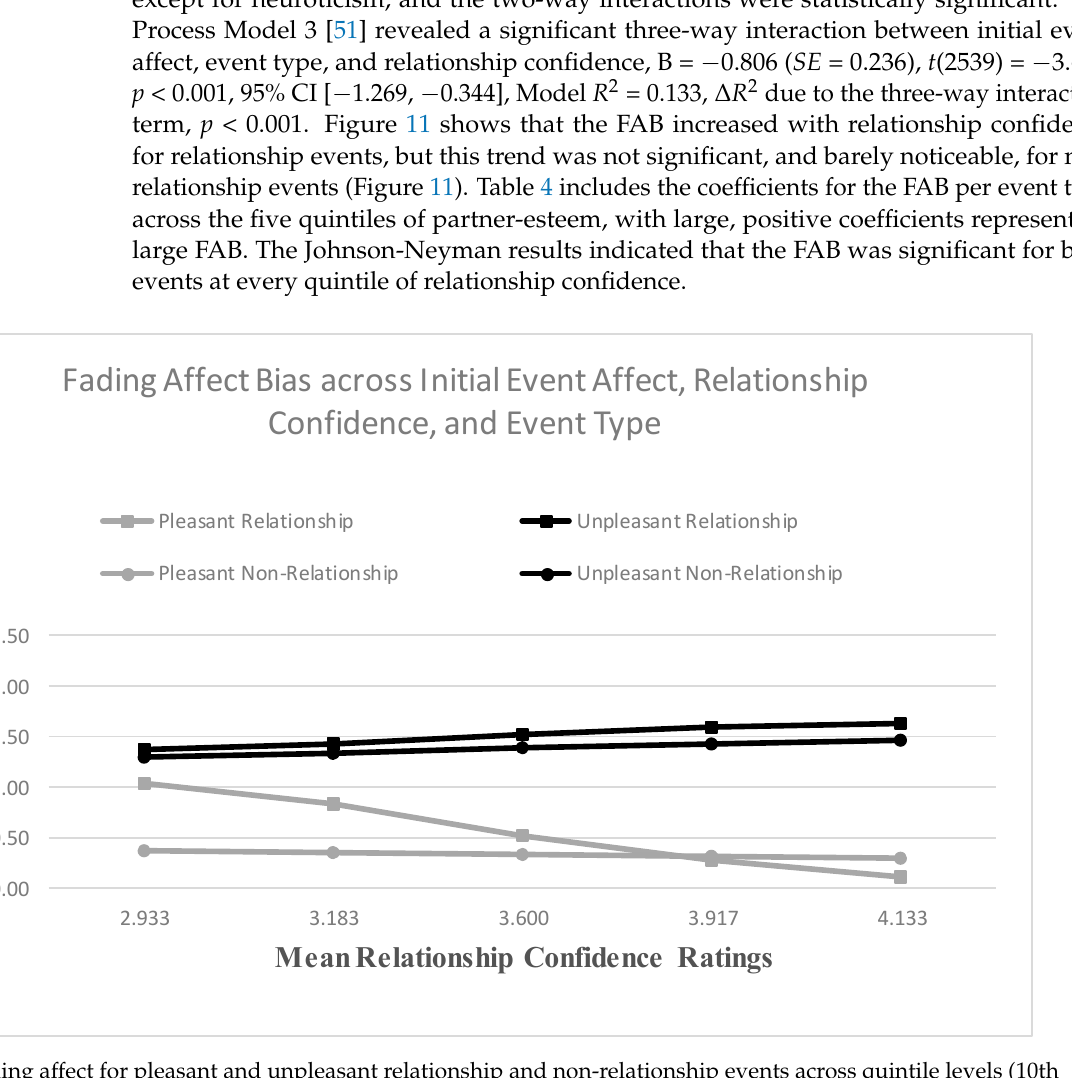
Figure 11. Fading affect for pleasant and unpleasant relationship and non-relationship events across quintile levels (10th through 90th) of relationship confidence. Table 4. Fading Affect Bias Regression Coefficients (SE) for Relationship Events and Non ‐ Relation ‐ ship Events across Quintiles (Mean Rating) of Relationship Confidence Ratings (large positive coef ‐ ficients represent large FAB).